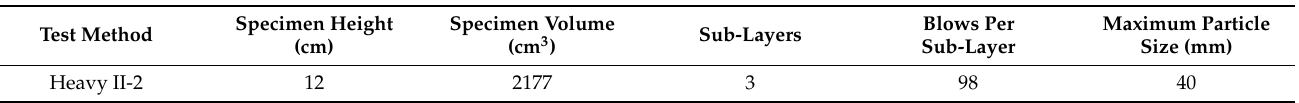
Table 3. The laboratory compaction test parameters as specified in the Chinese standard that was